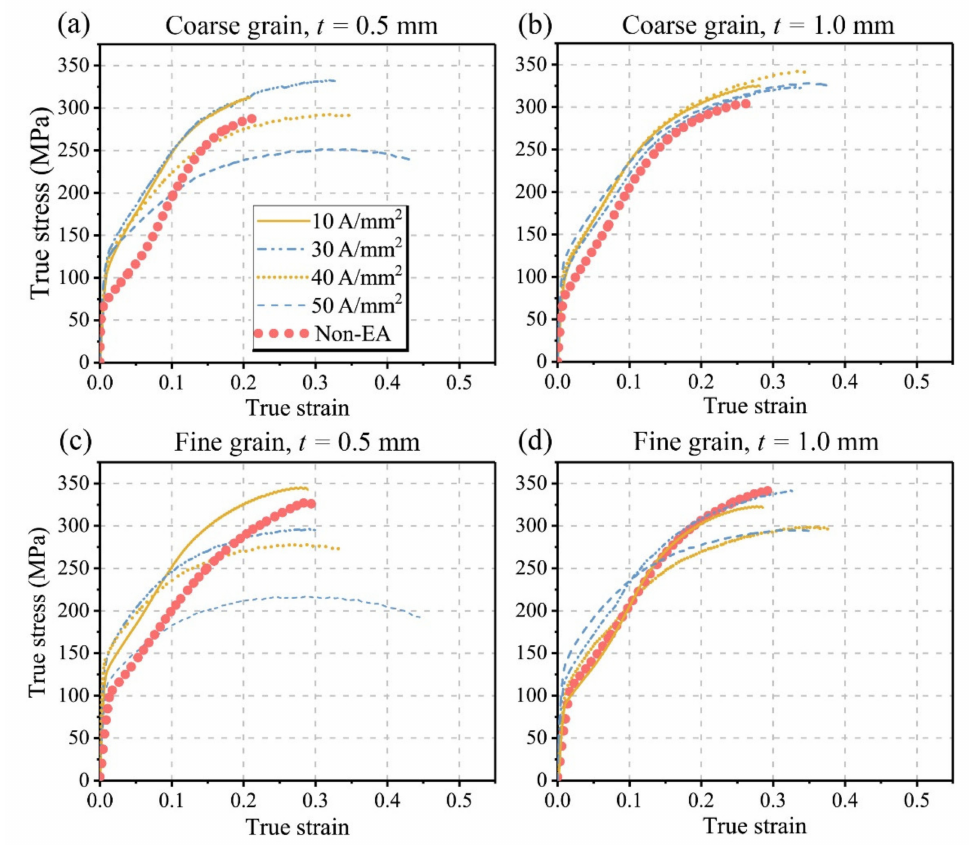
Figure 3. The true stress–strain curves of the EA and non-EA tensile tests of AZ31 foils with different grain sizes and thicknesses. ( a ) Coarse grain, t = 0.5 mm; ( b ) coarse grain, t = 1.0 mm; ( c ) fine grain, t = 0.5 mm; ( d ) fine grain, t = 1.0